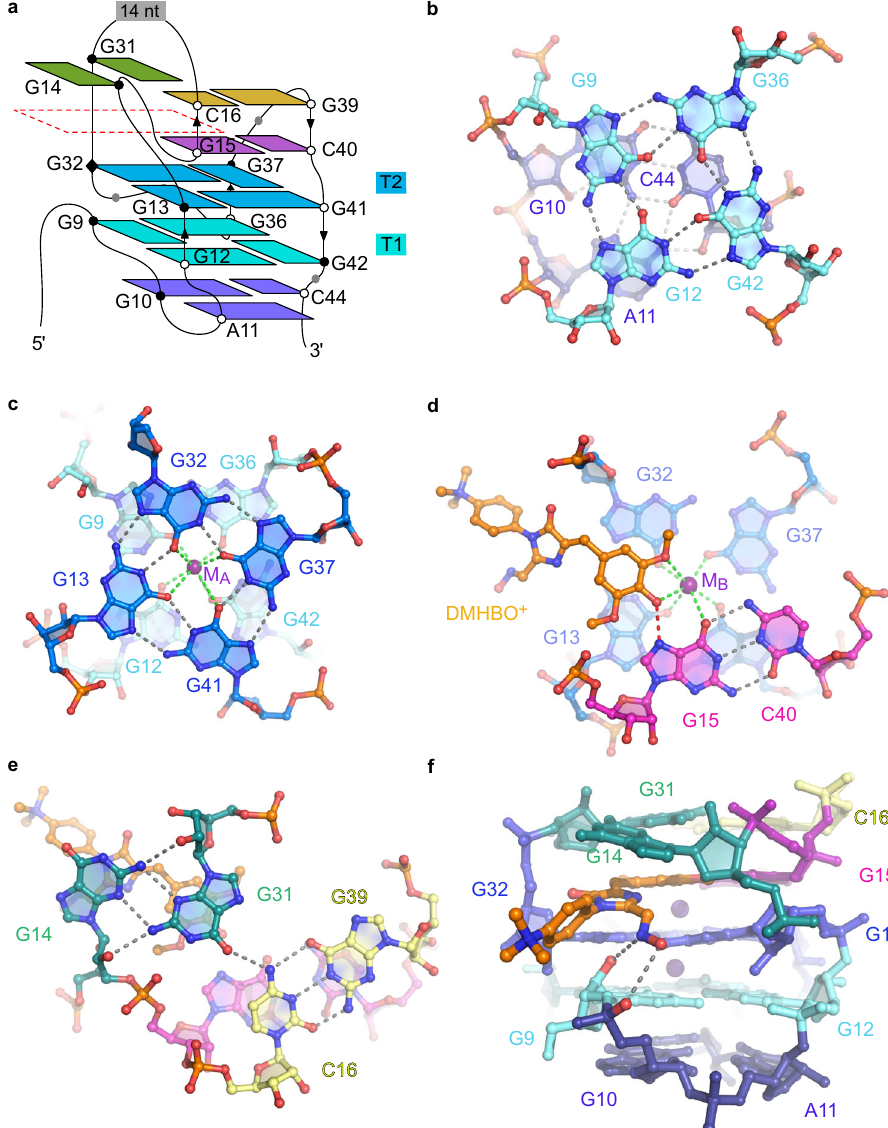
Fig. 2 Organization of the G-quadruplex and ligand binding site of the Chili aptamer. a Schematic representation of the connectivity and stereochemistry in the Chili aptamer core. White and black circles denote C3 ′ - endo and C2 ′ - endo ribose puckers, respectively. Black outline denotes anti conformation (all G ’ s in T1 and T2 are anti , except G32, which is high anti , as denoted by black diamond). The position of the ligand is outlined with the red dashed line. The color code of the nucleobases is as in Fig. 1 and is also used in panels b – f . b G-quartet T1 and the G10:C44:A11 base triple. c T1 and T2 with the central potassium ion M A , showing opposite polarity of the quartets with partial 5-5 stacking geometry. Gray and green dashed lines represent hydrogen-bonding and inner-sphere cation coordination, respectively. d The DMHBO + ligand is stacked on G-quartet T2 and coordinated with potassium ion M B and the G15: C40 base pair. The red dashed line represents a H-bond from the hydroxy group of the ligand to N7 of G15. e A trans sugar-sugar edge (tSS) base pair of G14 and G31 stabilizes DMHBO + via π -stacking interactions. O6 of G31 forms an additional hydrogen bond with the amino group of C16 in the C16:G39 base pair. f Stick representation of the ligand binding site showing hydrogen bonding interactions between the oxime moiety of the ligand and the RNA